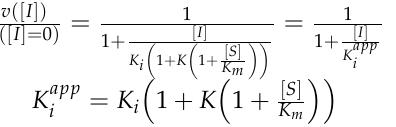
Table S10. Medicinal chemistry, drug-likeness, pharmacokinetics, hydrophilicity, and lipophilicity properties of Hyperoside; File S1. File input for the QVina software; File S2. File to run CPPTRAJ to obtain the top 10 PCs for the full conventional MD